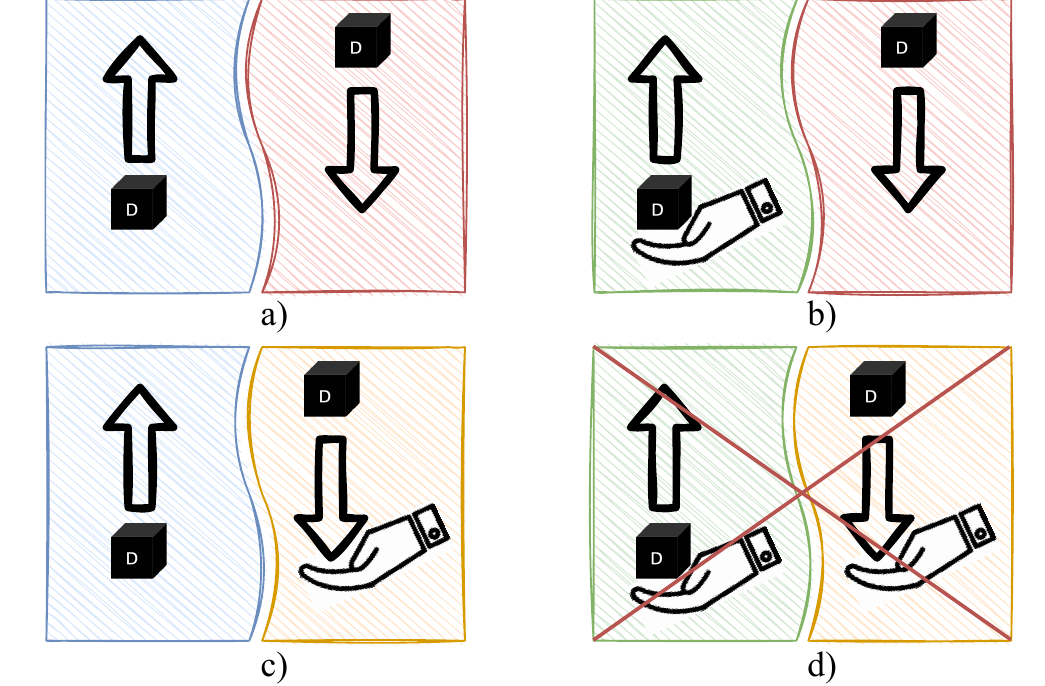
Figure 11. Complex operations: ( a ) Pick-Place, ( b ) Take-Place, ( c ) Pick-Give, and ( d ) Take-Give. The source and destination cube may be specified by any combination of the attributes position, color, and letter. The Cube Module then checks the start and target position by matching them with the cubes stored in the scene. If no position but color and/or letter was specified as a start cube, then the corresponding position is retrieved from the scene and the information is added to the CubeMessage . Contradictory CubeMessages are filtered out. When a CubeAction is verified, it is converted into one or, in the case of complex operations, two RobotActions and sent to the Robot Module